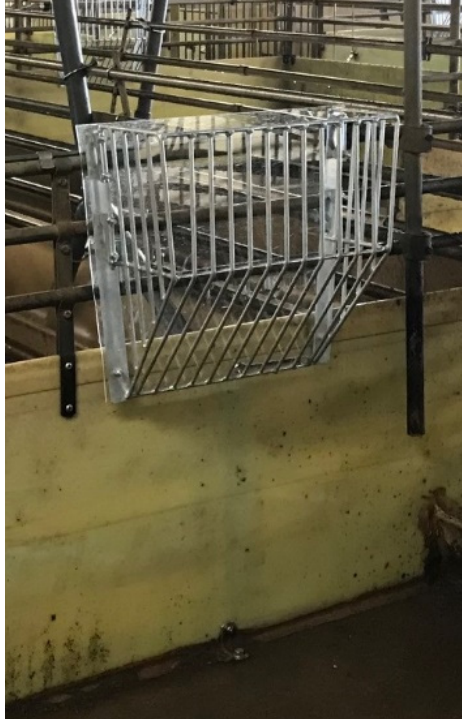
Figure 2. The rack was modified from a commercially available straw rack from JYDEN (3620-2012). The modification consisted of a plastic backplate and pipe clamps for mounting on the top pipes separating two adjacent pens. Length, 50 cm; height, 50 cm; width, 21 cm; 30 mm between bars.